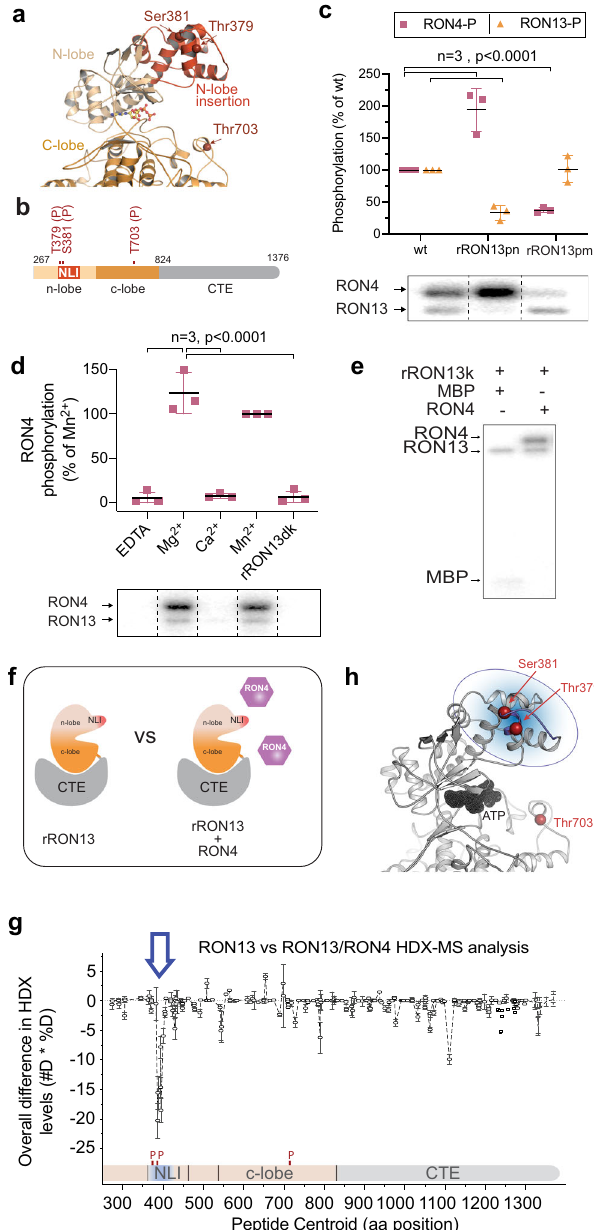
Fig. 7 RON4 is a direct substrate of RON13. a Partial view of the RON13 structure highlighting the autophosphorylation sites (arrows, red). Kinase domain (orange tones). NLI (N-lobe insertion). b Schematic representation of RON13 structure organization highlighting the autophosphorylated residues (red) mutated in this study. The kinase domain and the C-terminal extension (CTE) are colored in orange and gray tones. c Radioactive kinase activity assays comparing RON4 phosphorylation and RON13 autophosphorylation for different rRON13 phospho-mutants; phosphonull (RON13pn) and phosphomimetic (RON13pm). Autoradiograph of a representative radioactive kinase assay is shown below the graph. Data shown as mean ± SD normalized to wt ( n = 3 biologically independent experiments). P values were determined using a two-tailed paired t test. d Radioactive kinase activity assays characterizing the in fl uence of ions on rRON4 phosphorylation by RON13. Densitometry data (mean ± SD; n = 3 biologically independent experiments) were normalized to RON4 phosphorylation in presence of Mn 2 + . Statistical signi fi cance was determined using a two-tailed paired t test. e Autoradiograph from a radioactive kinase activity assays in presence of MBP (left) or RON4 (right) as a substrate. f Schematic representation of the two states analyzed by HDX-MS. The kinase domain and the C-terminal extension (CTE) are colored in orange and gray tones. NLI (red). RON4 (violet). g Differences in HDX rates between rRON13dk alone and in the presence of RON4. A single region encompassing amino acids 377 – 390 is protected by RON4, indicating the contact site between the two proteins. Data shown as mean ± SD; n = 3 biologically independent experiments. h RON13 kinase domain highlighting the RON4-binding site (residues 377 – 390; blue) identi fi ed by HDX-MS. This region corresponds to the NLI and encompasses the two phosphosites Thr379 and Ser381. Source data are provided as a Source data fi